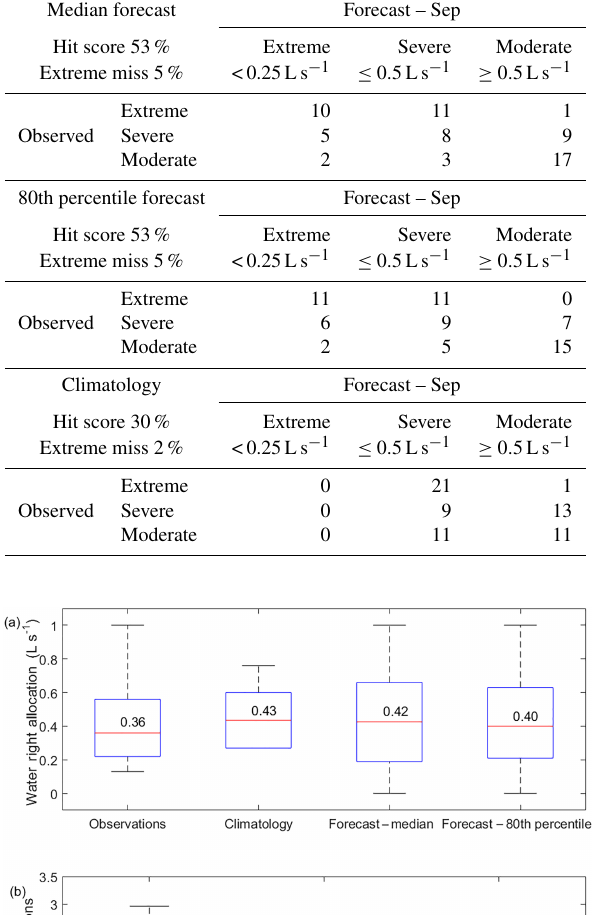
Table 5. Categorical water right allocation results: observed vs. forecast.